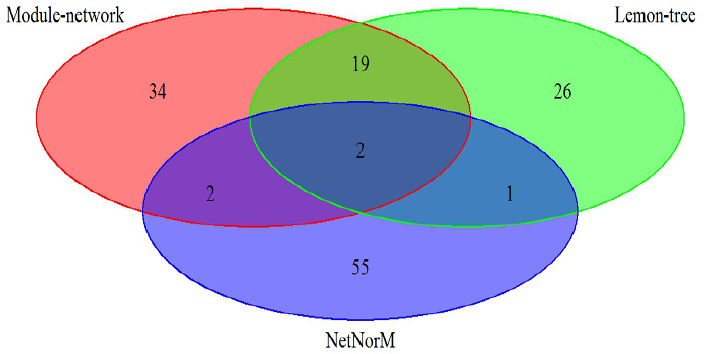
Figure 1. A comparison of identified cancer drivers between module-network and two state of the integrative methods on breast cancer subtypes